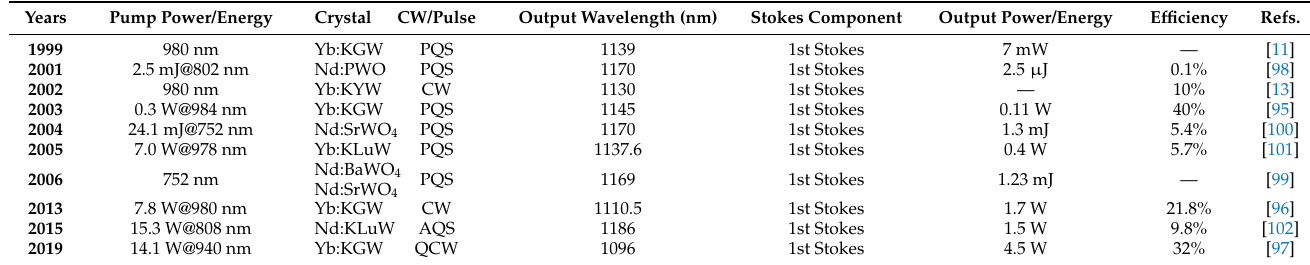
Table 8. Research progress on tungstate self-Raman lasers.